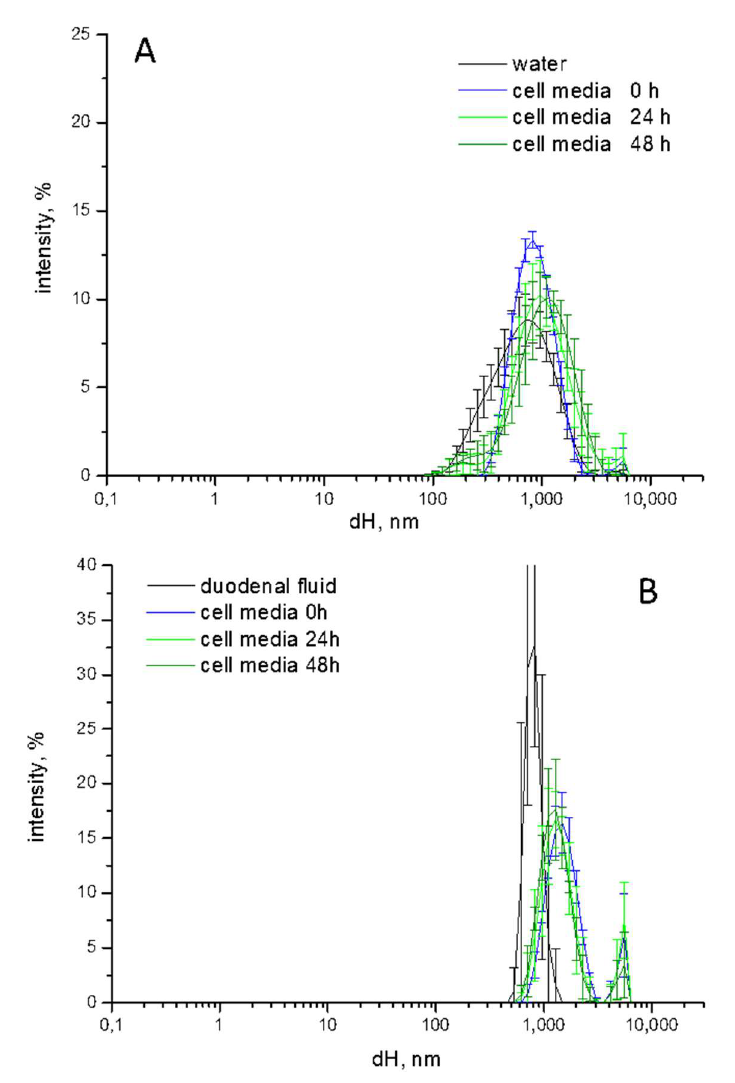
Figure 8. d H distribution of ( A ) pristine and ( B ) pre-treated TiO 2 -NM1 during the incubation in McCoy’s 5a medium + fetal bovine serum (10%). Hydrodynamic diameters (d H ) distribution (% intensity) is expressed as mean value of 5 measurements in three independent experiments ± SD.